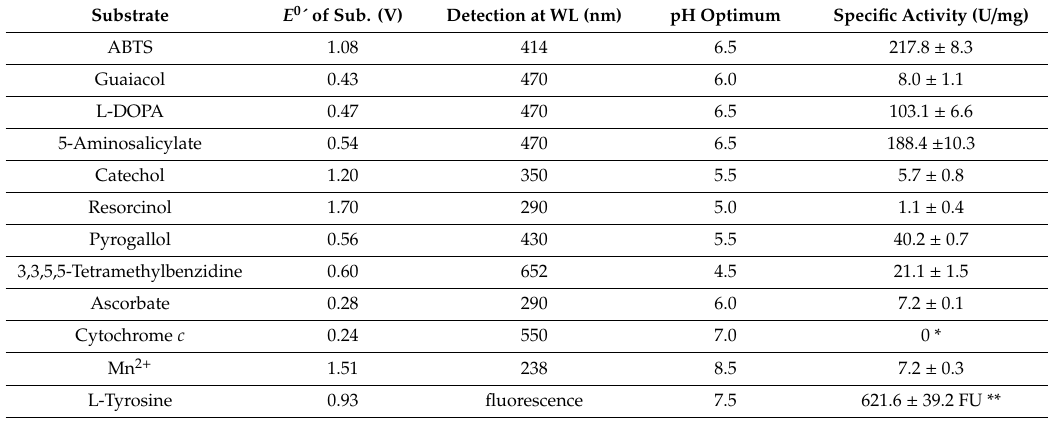
Table 3. Specific peroxidase activity of secreted metal chelate a ffi nity chromatography (MCAC)-purified MoHyBPOX1 with various electron donors at each determined pH optimum, recorded at 30 ◦ C. All values are means ± standard deviation. For comparison, standard reduction potentials ( E 0’ in (V)) for used electron donors obtained from the literature are given in the second